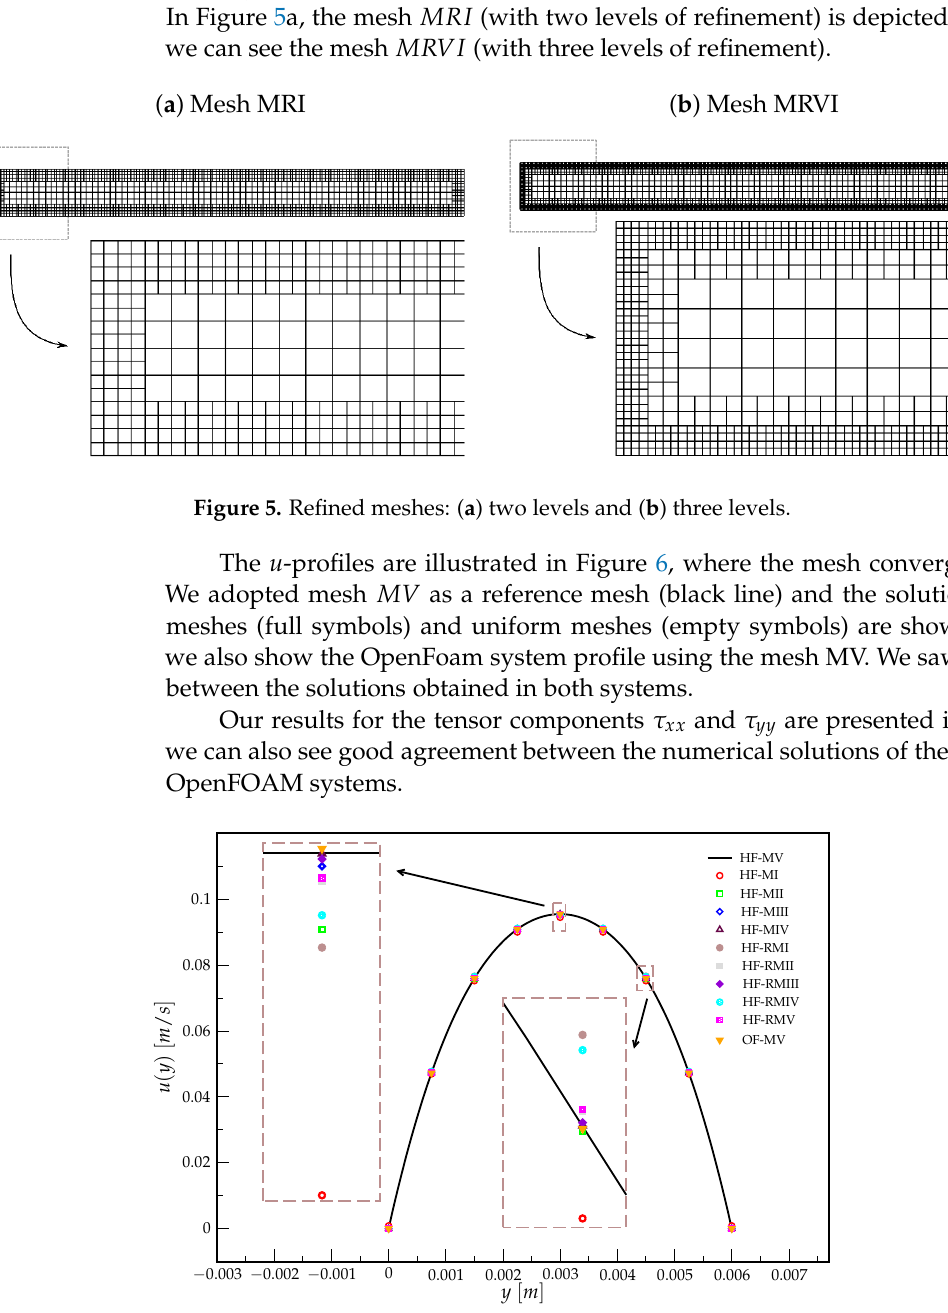
Figure 6. The u -profiles used by simulation of channel